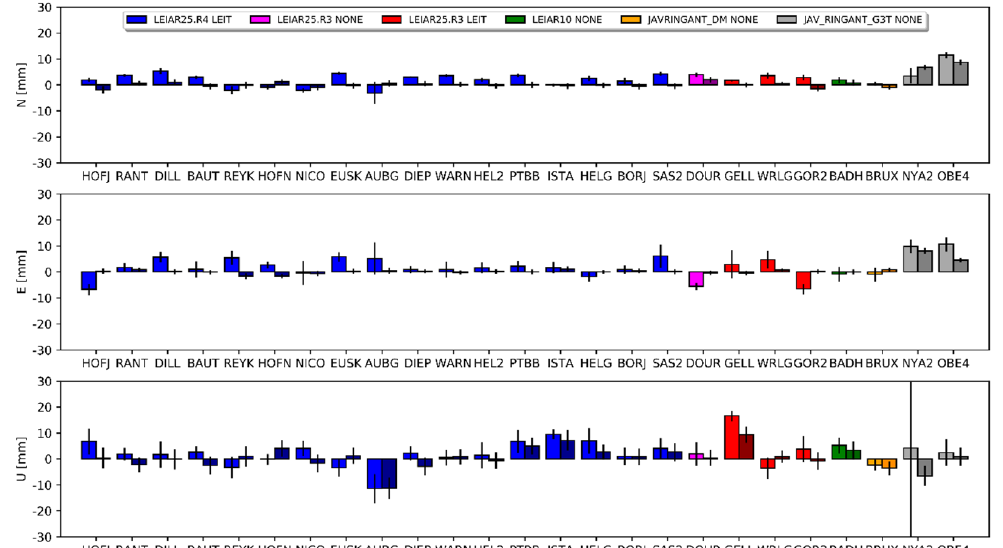
Figure 8. Coordinate differences between the E2 and G1 solutions and their standard deviations. Darker columns refer to the DD approach. Values are presented in Table A4.